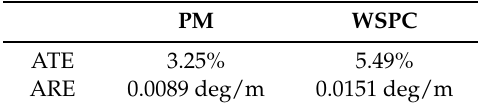
Table 4. Comparison of ego-motion estimation error for scenario 2.